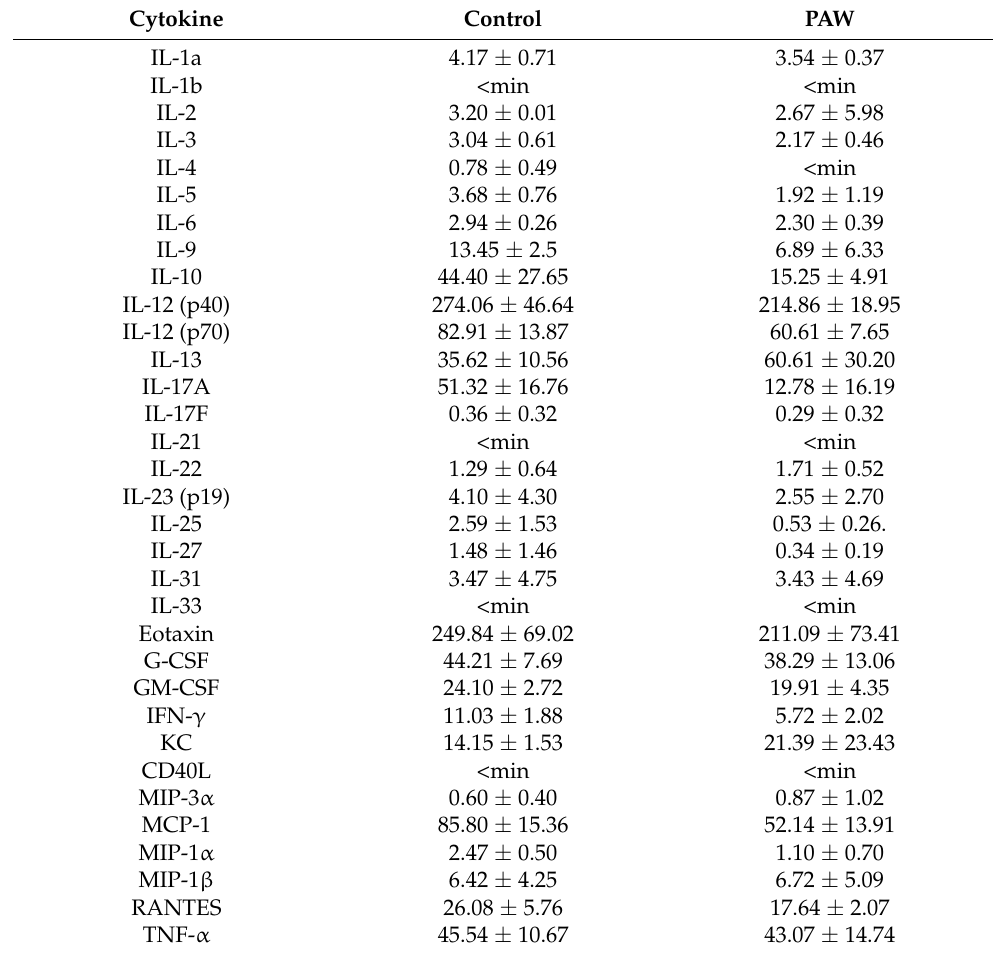
Table 5. Cytokine levels in CD1